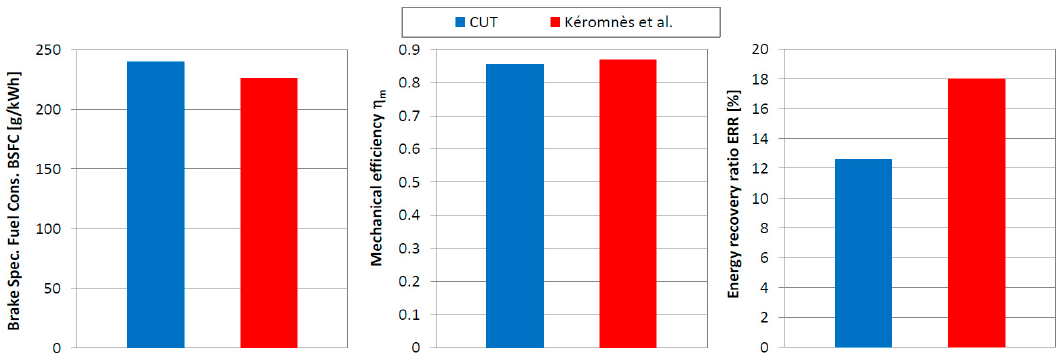
Figure 16. Comparison of the best results obtained for the engine developed at CUT and that developed by Kéromnès et